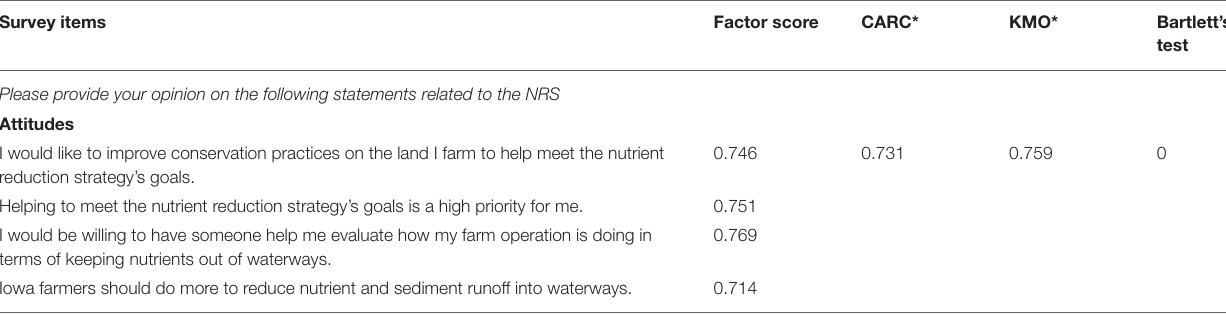
TABLE 1 | Factor scores and reliability tests for farmers’ attitudes toward the Iowa nutrient reduction strategy. Survey items